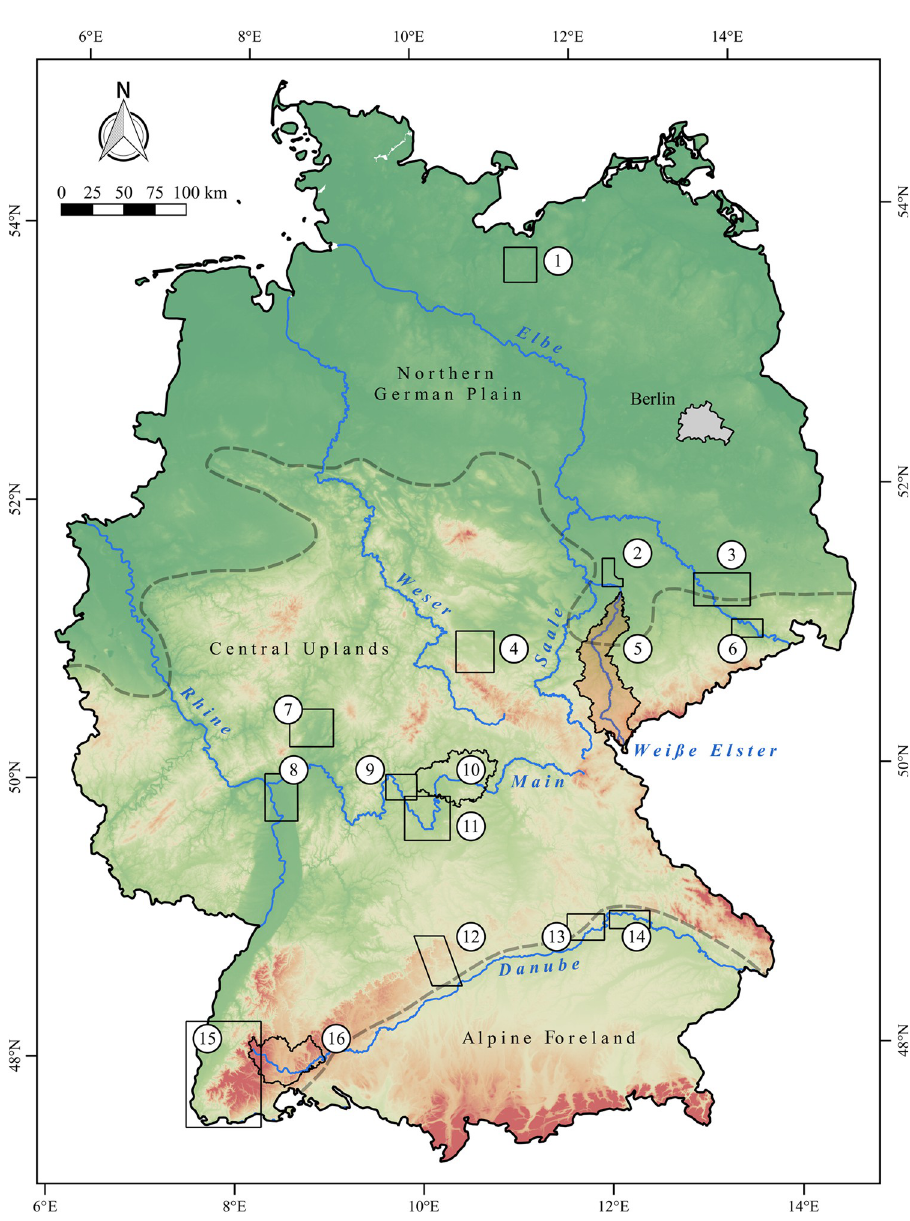
Fig 1. Diachronic studies with a focus on statistical analyses of long-term human-environment interactions between the Neolithic and the middle ages in Germany. (1) Region between Lake Schwerin and Stepenitz [58], (2) north-west Saxony [57], (3) former district of Riesa-Großenhain [56], (4) Gotha landscape [33], (5) Weiße Elster river catchment (present project), (6) widening of the Elbe valley at Dresden [41], (7) northern Wetterau [59], (8) district of Groß-Gerau [29], (9) north-western Main triangle [55], (10) eastern landscape of Lower Franconia [54], (11) southern Main triangle [9], (12) Brenz-Kocher valley in the eastern Swabian Jura [10], (13) lower valley of the Altmu¨hl river [53], (14) Danube valley near Regensburg [52], (15) southern Upper Rhine valley [32] and (16) the Baar and adjacent landscapes [12]. Furthermore, the three main landscape units of Germany are shown. Rivers are derived from the European Catchments and Rivers network system [60]. The topography is based on the SRTM 90 m Digital Elevation Database version 4.1 [61–63].